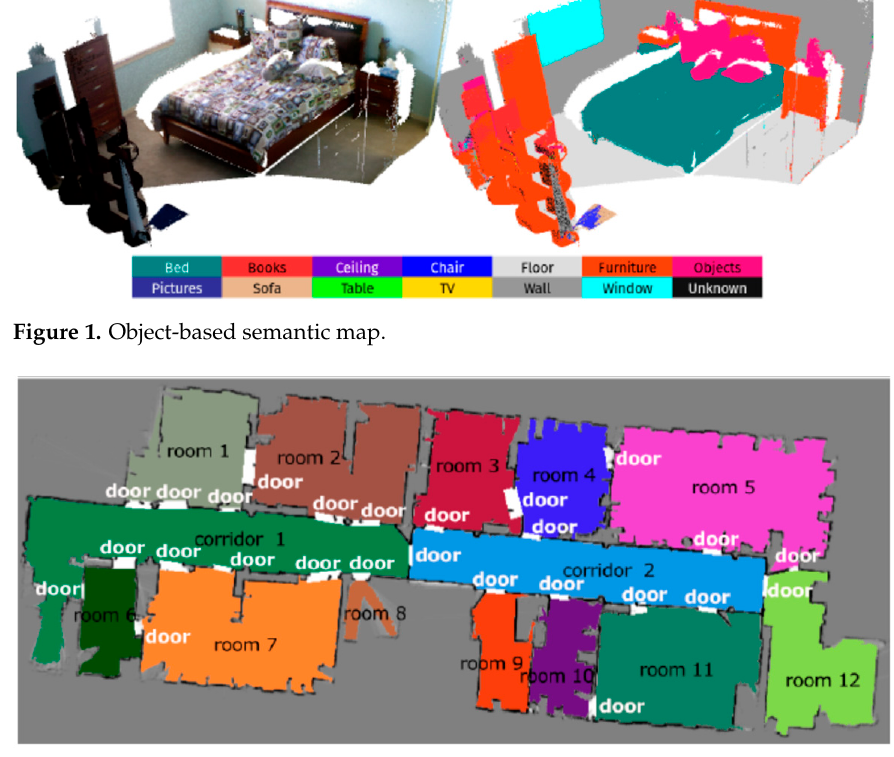
Figure 2. Region-based semantic map.